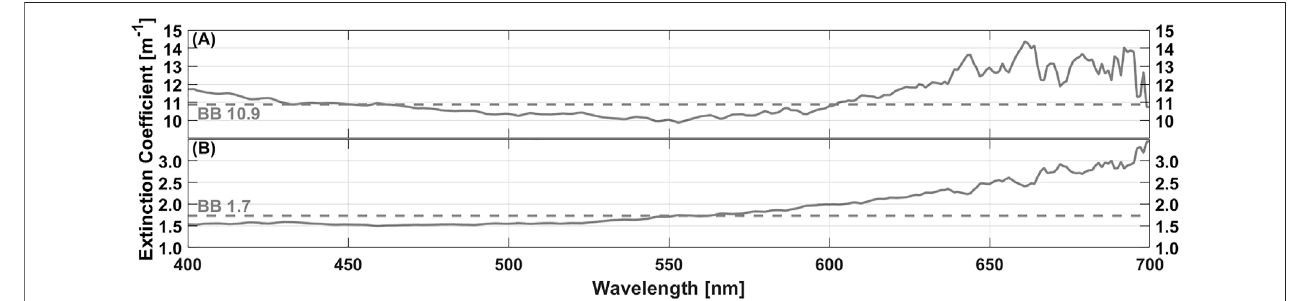
FIGURE 5 | Spectral snow k s ( λ ) (A) and sea ice k i ( λ ) (B) extinction coef fi cients as retrieved by inversion of a two-layer RT model. Trans fl ectance, laser scanner snow depth, and EM31-SH ice thickness used for the retrieval were measured at the marker locations on 22, 23, and 24 May, respectively. The broadband values (BB) are indicated by the numbers and the dashed